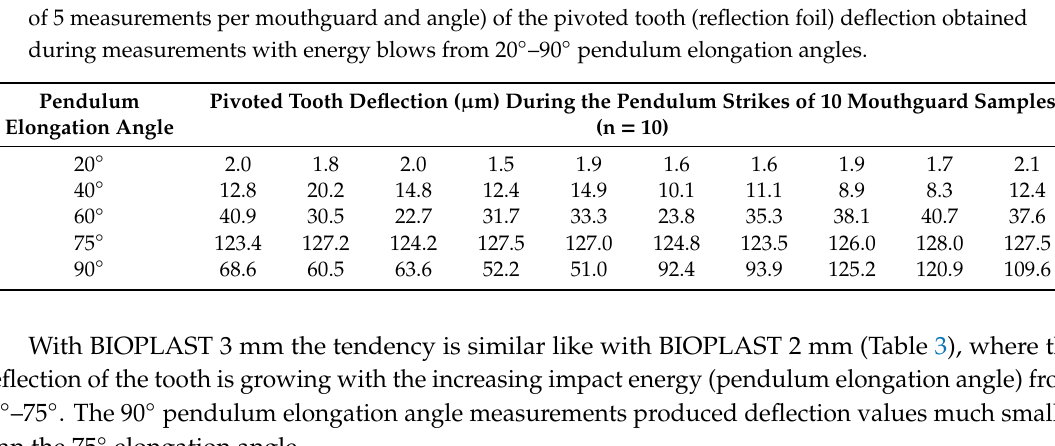
Table 3. BIOPLAST 3 mm mouthguard measurements: Average values of maximum amplitudes (mean of 5 measurements per mouthguard and angle) of the pivoted tooth (reflection foil) deflection obtained during measurements with energy blows from 20 ◦ –90 ◦ pendulum elongation angles.